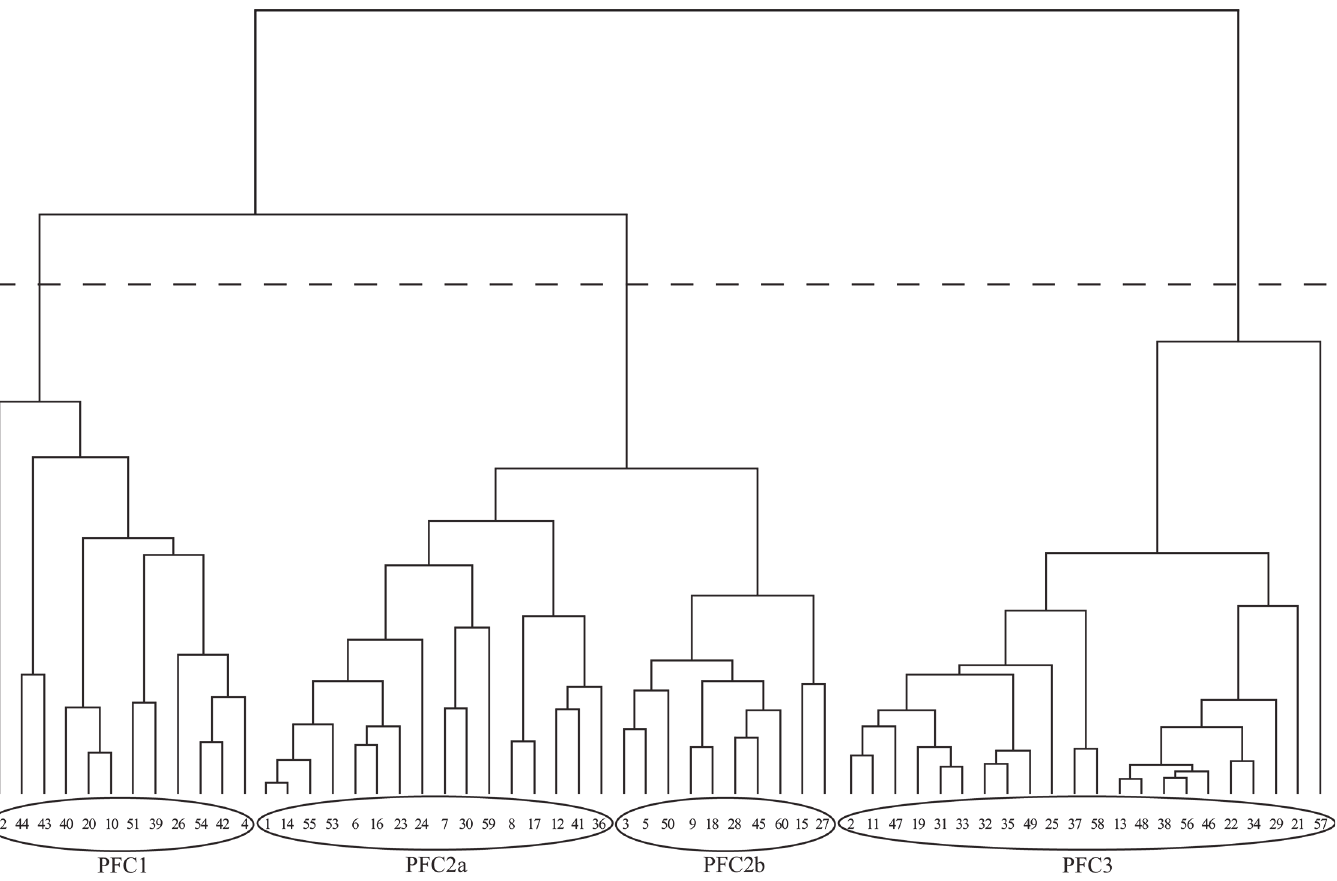
Fig 2. Dendrogram of the hierarchical cluster analysis of the mean values of the Fourier components for each phenological unit. The dashed line indicates the cutting level of the dendrogram. Circles indicate the grouping of the phenological units (PUs) into four clusters, named phenological fuel classes (PFCs), based on their phenological similarity in terms of vegetation seasonality and